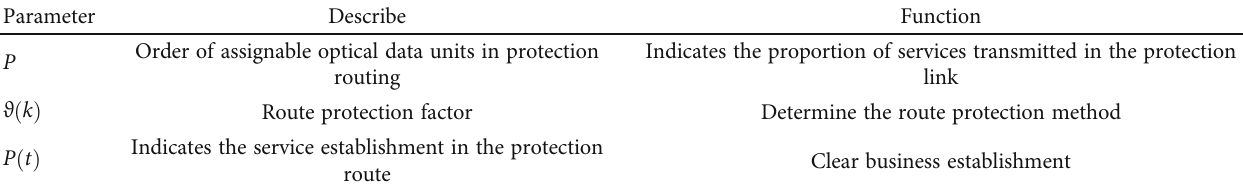
Figure 2: Intelligent network teaching. Table 1: Parameters to be added to the intelligent network